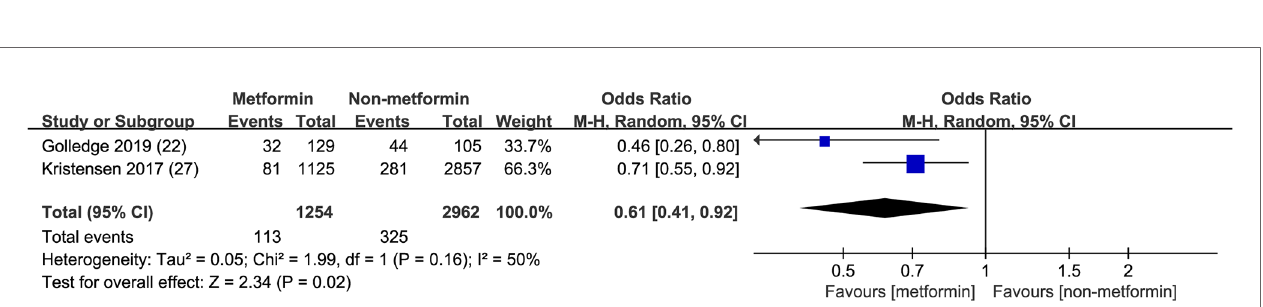
FIGURE 7 | Assessment of the effect of metformin on incidence of AAA after excluding Fujimura 2016. AAA. Forest plot of studies assessing the effect of metformin on incidence of AAA events after excluding Fujimura 2016.